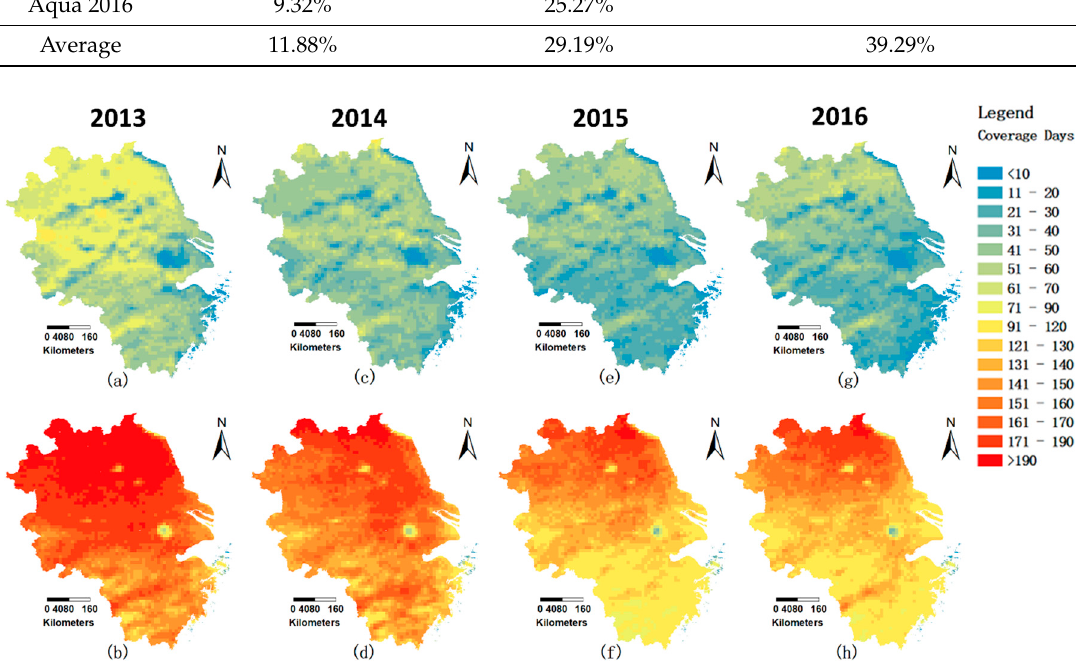
Figure 3. Annual coverage days of MODIS standard AOD product and fused daily average AOD from two-stage IVW in the YRD during 2013–2016 (a), (c), (e) and (g): the MODIS standard AOD; (b), (d), (f) and (h): the fused daily average AOD from two-stage